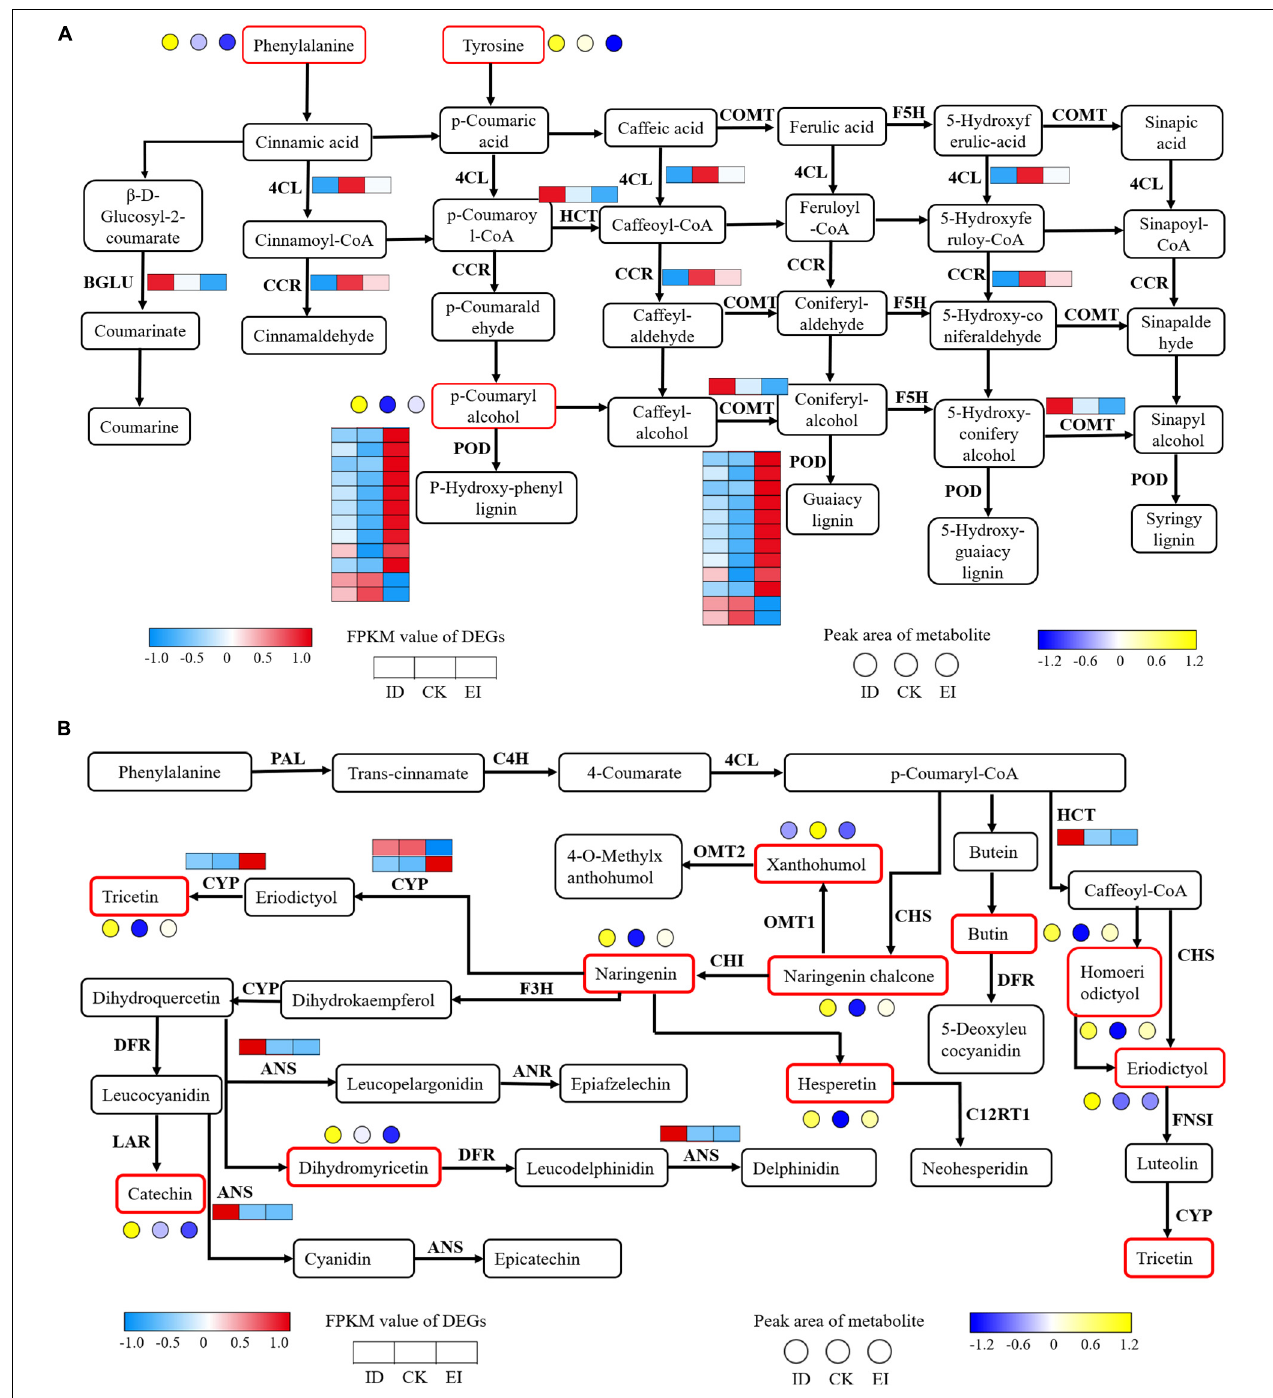
FIGURE 10 | Transcriptomic and metabolomic variation related to phenylpropanoid (A) and flavonoid (B) metabolism. 4CL, 4-coumarate CoA ligase; BGLU, beta-glucosidase; CCR, cinnamoyl-CoA reductase; COMT, caffeic acid 3-O-methyltransferase; F5H, flavanone 5-hydroxylase; PAL, phenylalanine ammonia-lyase; C4H, cinnamic acid 4-hydroxylase; CHS, chalcone synthase; CHI, chalcone isomerase; F3H, flavanone 3-hydroxylase; DFR, dihydroflavonol 4-reductase; ANS, anthocyanidin synthase; FLS, flavonol synthesis; ANR, anthocyanin reductase.